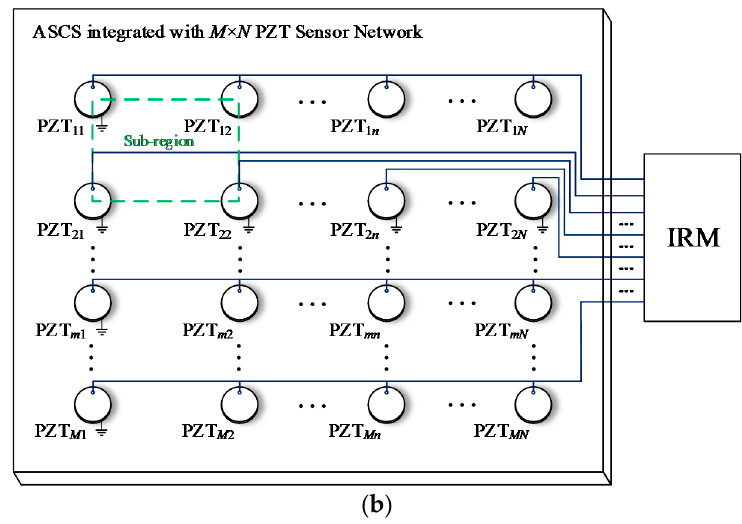
Figure 12. The architecture of CHSN when: ( a ) N is even; ( b ) N is odd.